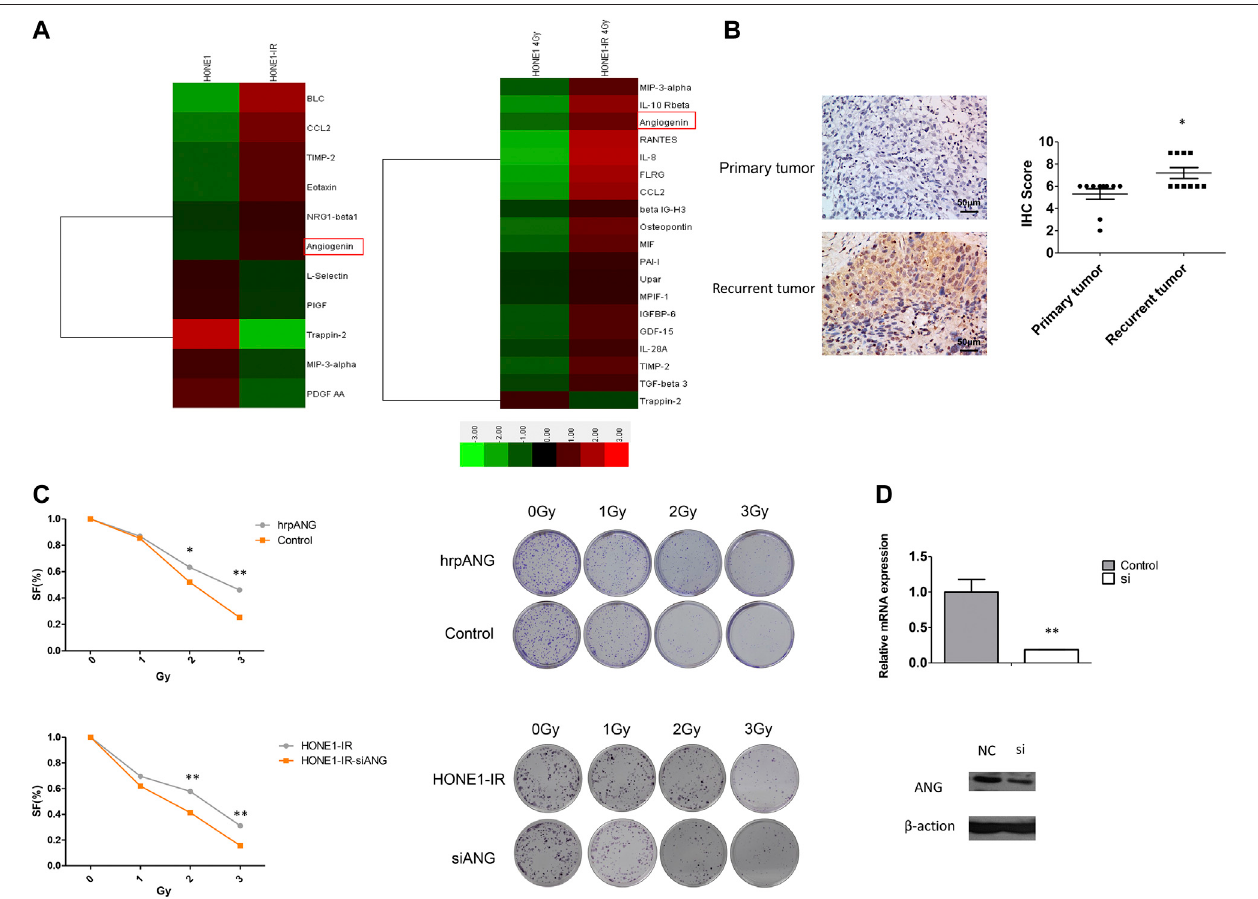
FIGURE1| Angiogenin(ANG)expression waselevated inradioresistantNPCcellsandrecurrenttumourtissues. (A) Heatmaps showtheexpressionpatternof11 genes in HONE1 vs. HONE1-IR cells and 19 genes in HONE1 vs. HONE1-IR cells after 4-Gy irradiation, derived from unsupervised clustering analysis. Red or green re fl ects high or low expression, respectively, as indicated in the scale bar (Raw Z score). (B) The differential IHC scores of tumour tissues, regarding ANG expression, from 10 patients with NPC before initial treatment and after tumour recurrence in the same patients. * p < 0.05 following nonparametric tests. (C) The human recombinantproteinANG(hrp-ANG)ledtoincreasedradio-resistance,asseenbycolonyformationassaysinHONE1cells(upperpanel).Radiationsensitivitywastested by colony formation assays in HONE1-IR cells and those transfected with CCL2-siRNAs (lower panel). Survival curves are constructed based on means ± SEM; * p < 0.05, ** p < 0.001. (D) ANG mRNA expression and protein expression were signi fi cantly decreased in HONE1-IR cells transfected with ANG-siRNAs.